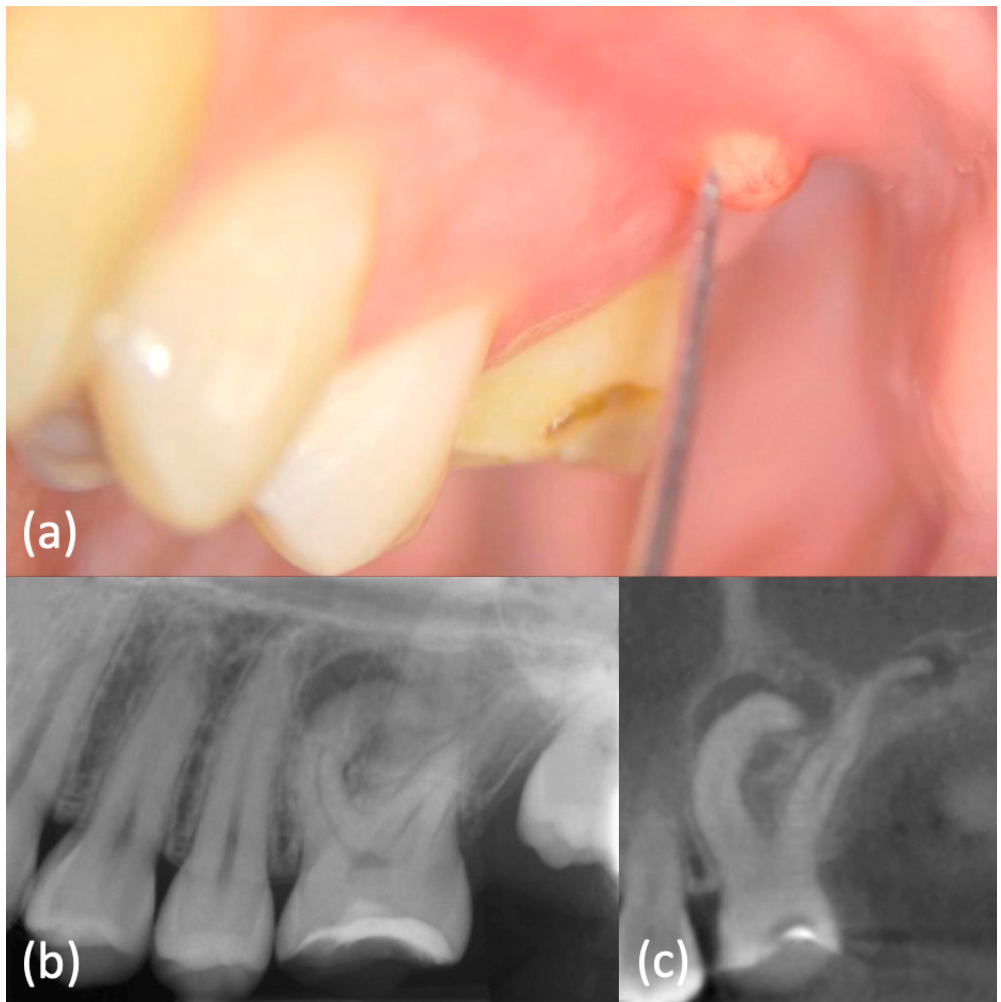
Figure 6. ( a ) Intraoral examination showed a lump on buccal side of element 2.6, which appeared not to be completely erupted and with a carious lesion. Element 2.7 was clinically absent. ( b ) Periapical X-ray showed dilacerated roots of element 2.6, with a periapical lesion on the mesial-buccal one. Element 2.7 was not erupted, but present. ( c ) CBCT confirmed these findings and highlighted a periapical lesion also on the other roots.